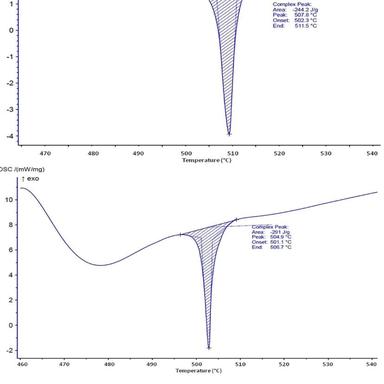
H500 DSC results after one freeze/melt cycle (up) and twenty freeze/melt cycles (down).